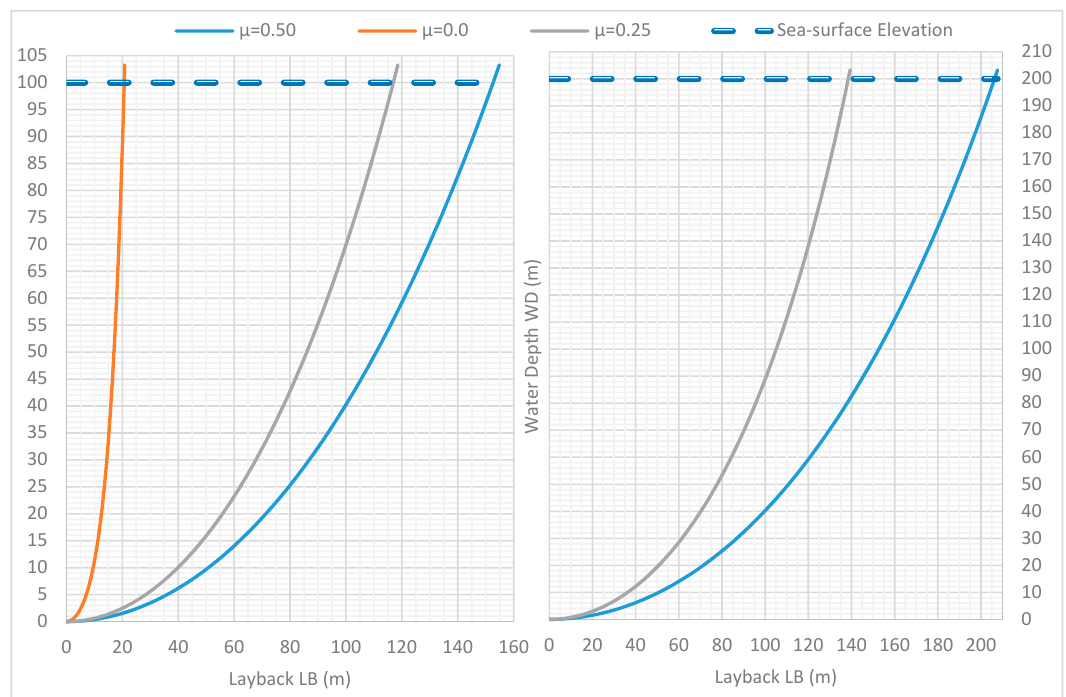
Figure 22. Cable configuration for CS1 assuming different friction coefficients at 10 m and 50 m water depth.